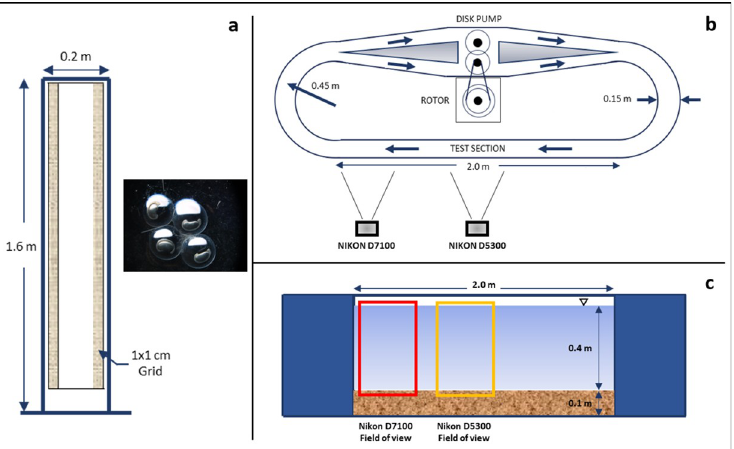
Fig 1. Facilities used to conduct the experiments (not to scale). (a) Settling water column with an inset of microscope image of the eggs. (b) Plan view of Race-Track Flume (RTF), Odell-Kovasznay type flume, with the